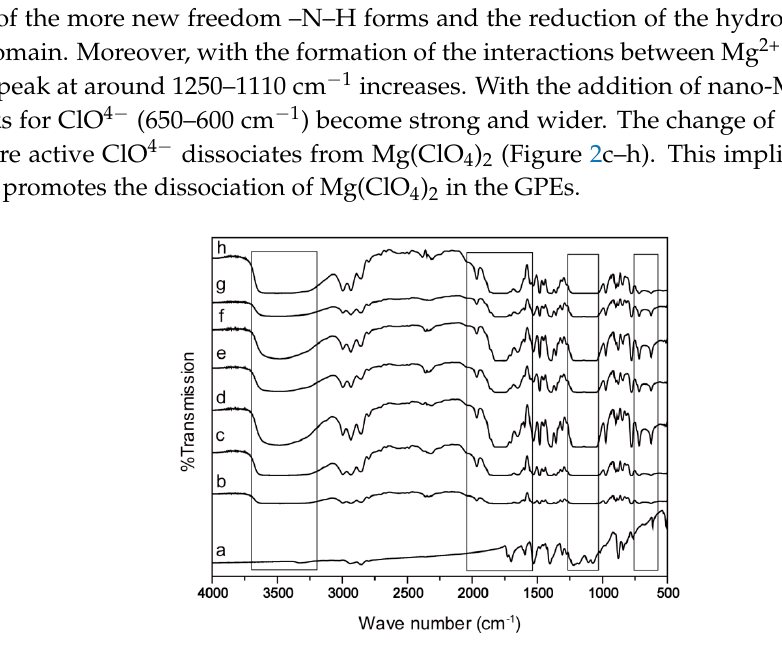
Figure 2. The Fourier transform infrared spectrometer (FTIR) spectra of the samples: ( a ) the membranes without MgO fillers, ( b – h ) the gel polymer electrolytes (GPEs) with different content of nano-sized MgO; ( b ) 0%; ( c ) 1%; ( d ) 3%; ( e ) 5%; ( f ) 7%; ( g ) 10%; and ( h ) 15%.